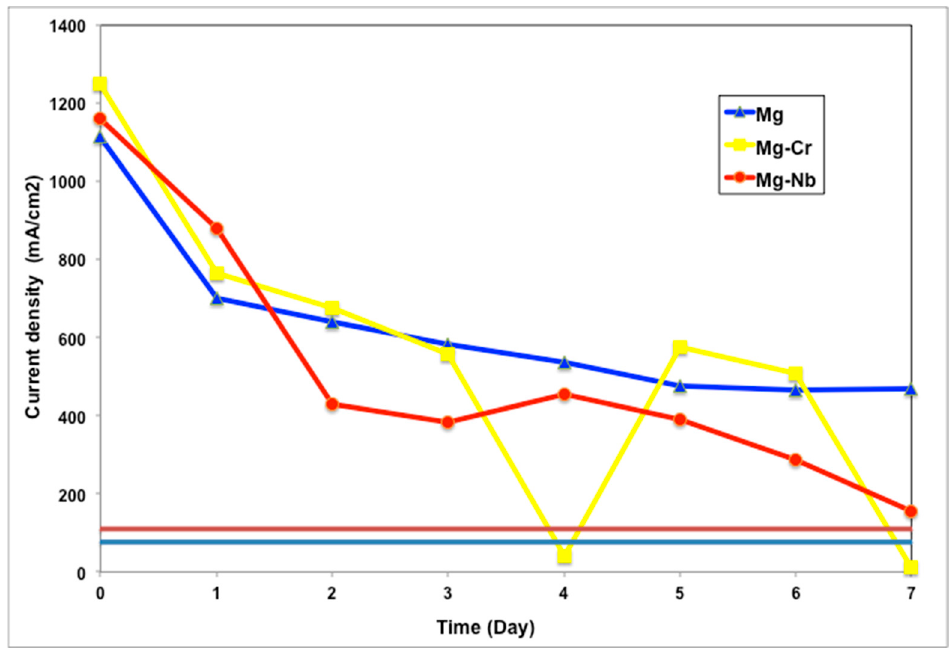
Figure 14. Current density (i) in the function of the immersion time in seawater for X52 steel cathodically polarized for the three anodes.